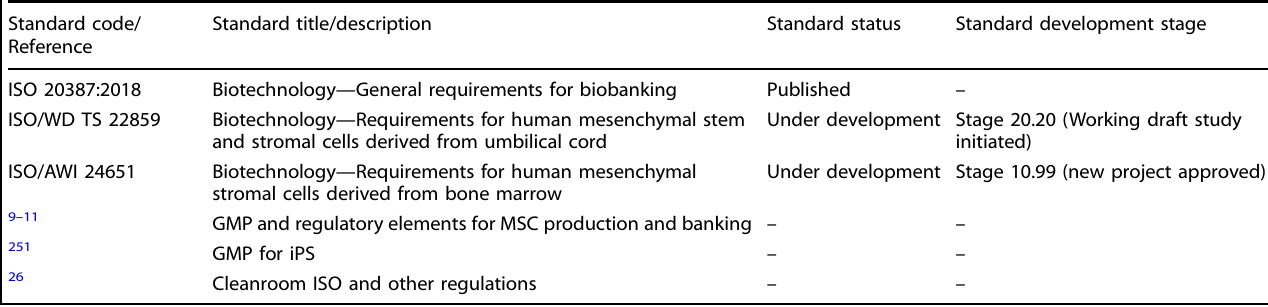
Table 1. Standards and GMP literature applicable to cell